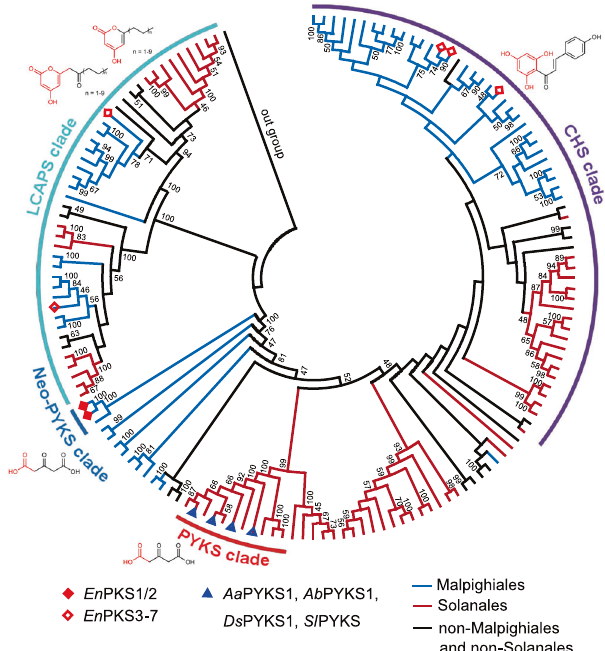
Fig. 5 | The phylogenetic tree of PKSs in Malpighiales and Solanales species. Chalcone synthase (CHS) clade; pyrrolidine ketide synthase (PYKS) clade in Sola- nales;neo-pyrrolidineketidesynthase(Neo-PYKS)cladeinMalpighiales;long-chain alkyl α -pyrone synthase (LCAPS) clade. The structures of the PKS products are shown in the phylogenetic tree. A fully annotated phylogram is available in Sup- plementary Fig.